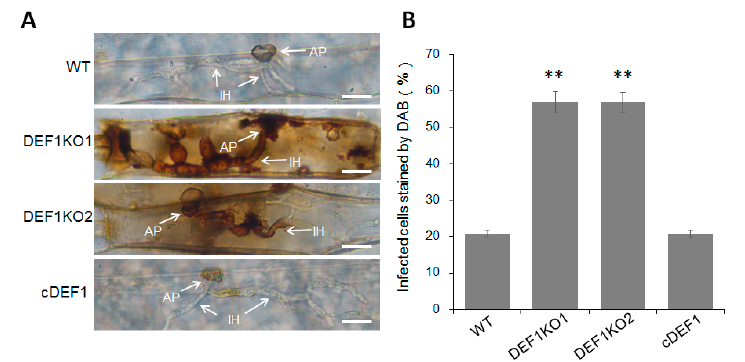
Figure 6. DAB staining assay. ( A ) Barley epidermis cells were inoculated with different strains and then stained with DAB at 30 hpi, and observed after decolorization. Arrows indicate appressoria (AP) and infection hyphae (IH). Bar = 20 µ m. ( B ) Percentages of infected cells which stained by DAB. Significant differences are labelled with asterisks (**, p < 0.01). WT, wild type; DEF1KO1 and DEF1KO2, two independent def1 knock out mutants; cDEF1, complementary strains.